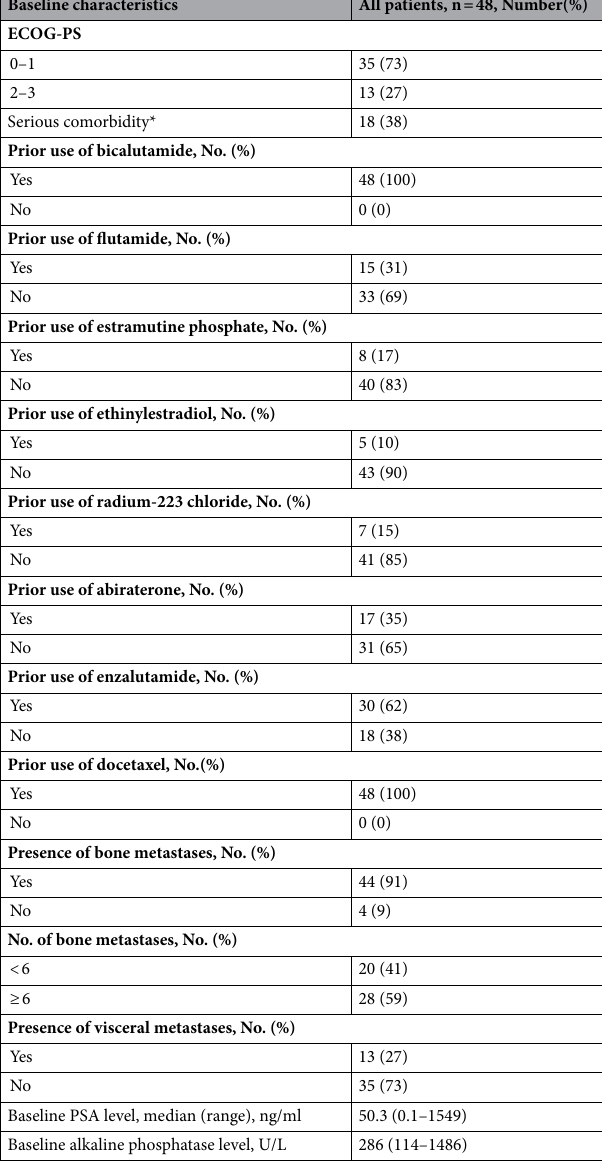
Table 2. Baseline characteristics of patients with mCRPC before cabazitaxel treatment. *Include diabetes, post-myocardial infarction, post-cerebrovascular accident, liver injury, pulmonary obstructive disorder, arteriosclerosis obliterans, and other active